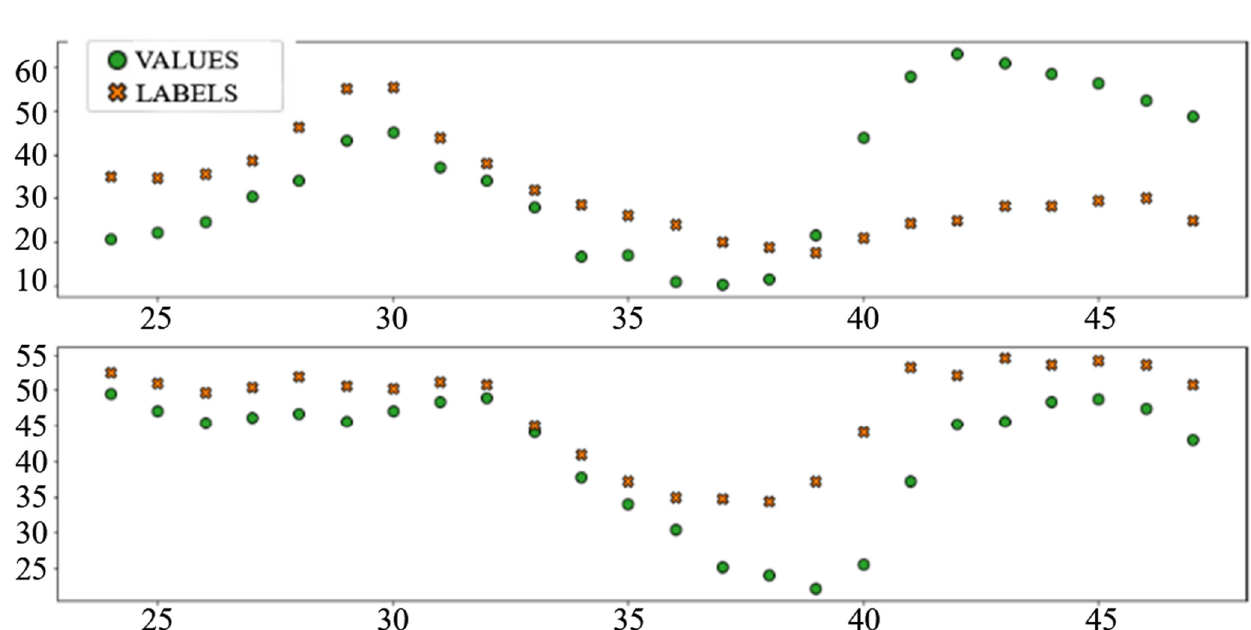
Figure 8. Price prediction: benchmark model “naïve”. Due to the nature of the prediction (only the last 24 h of the input window are considered) the prediction naïve for naive model are marked 24–47 on the X -axis, instead of 336–359.